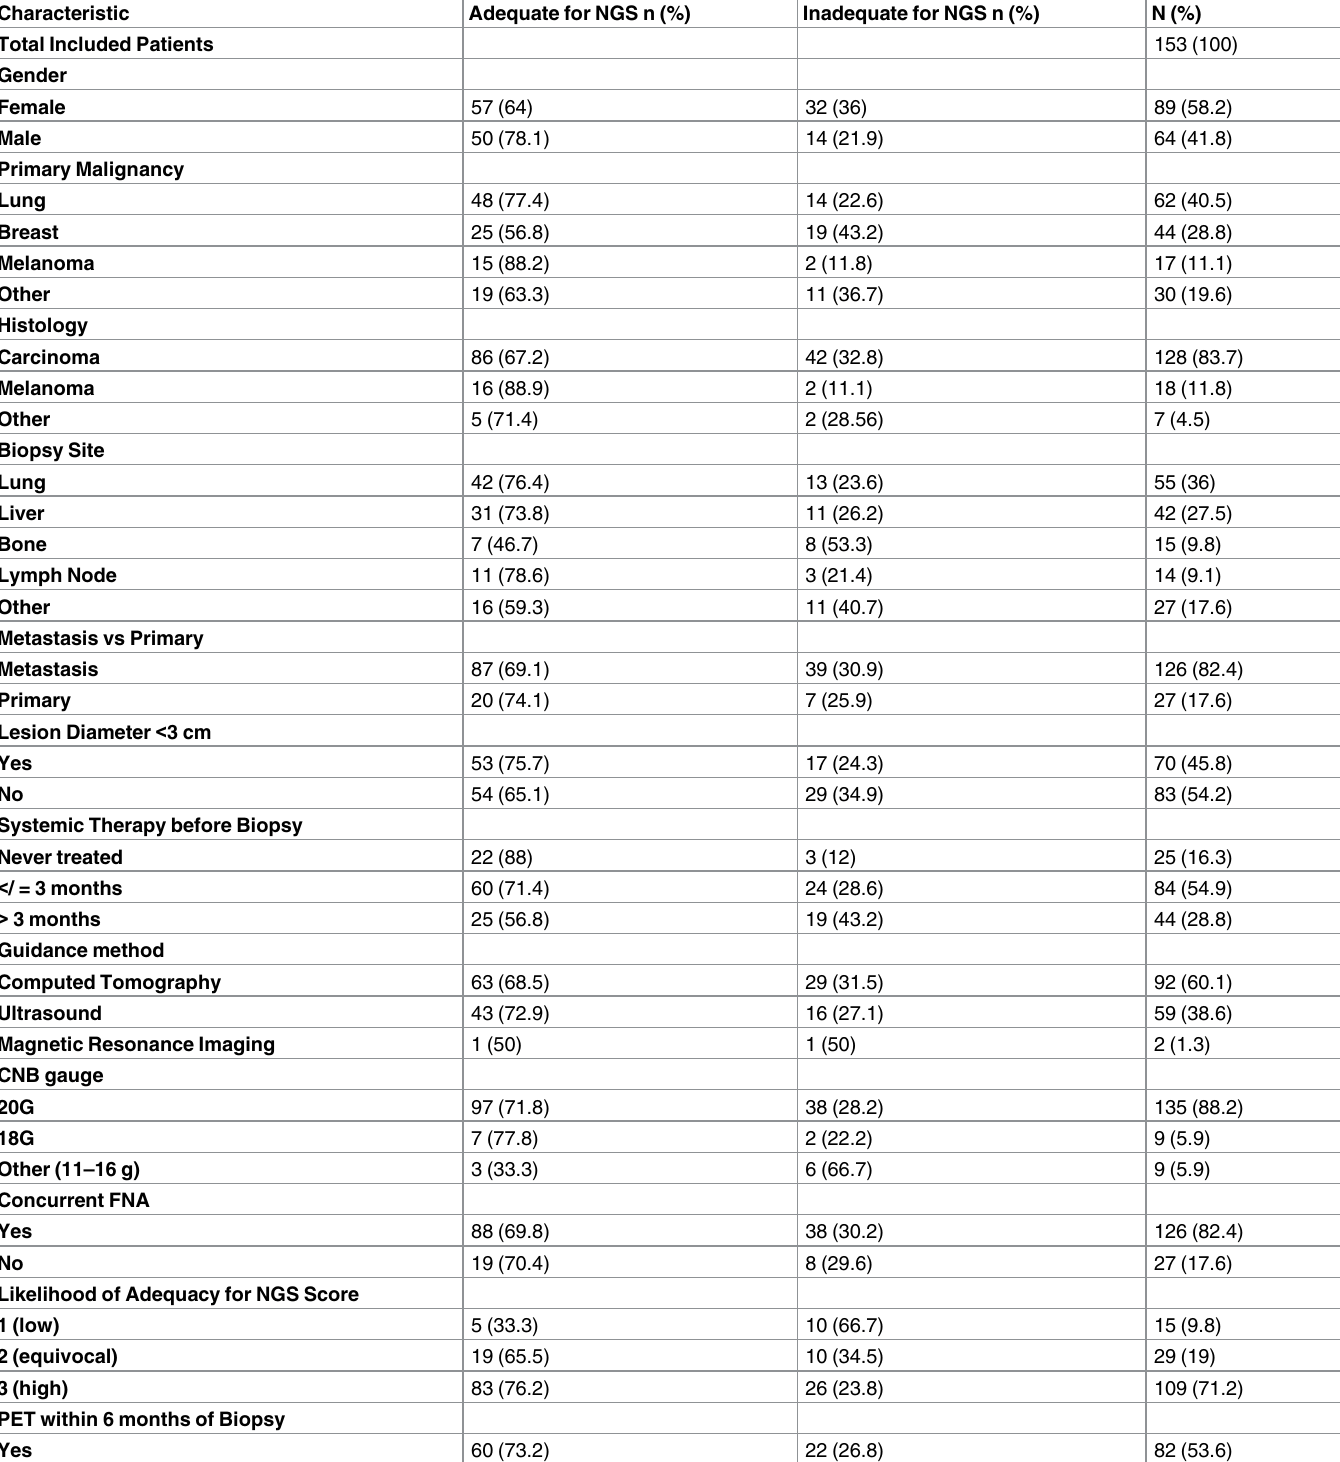
Table 2. Patient and technique variables with adequacy for NGS of biopsy